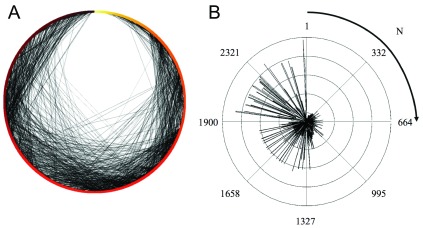
The growth in network complexity within the kDAG showing edge effects and node connectedness.By sorting the kDAG radially by order of entry into the population (date of entry indicated by color in
A; order of entry (N) indicated by radial position in
A and
B), change in graph connectedness is indicated by the increasing density of directed edges over time (
A, grey edges) and the closeness centrality of nodes (
B). The closeness centrality of a node is a measure of the mean path length required to reach all nodes in a graph from that node (
16). Unlike other centrality measures, closeness centrality incorporates information from all paths between nodes, not just the shortest mean path. Higher closeness centrality indicates higher connectedness, with a baseline closeness centrality of zero for an unconnected node.